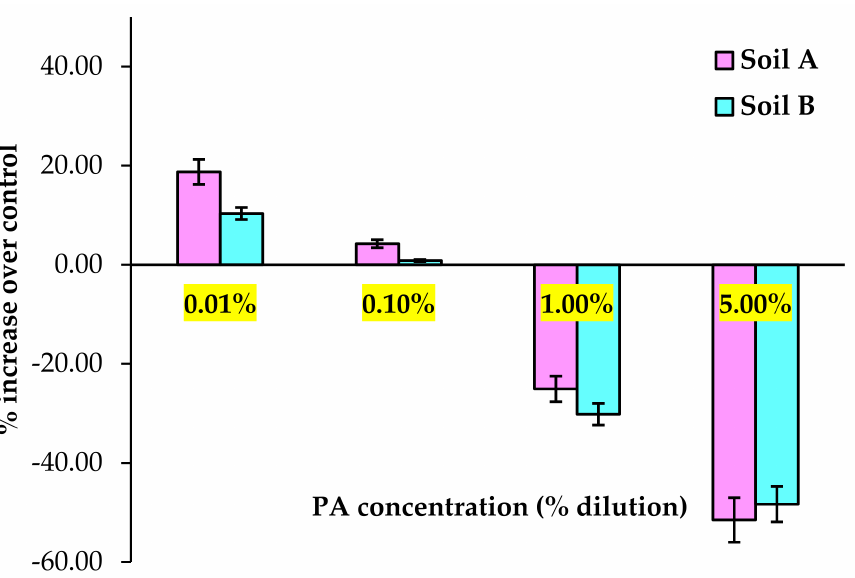
Figure 1. The effect of PA on soil dehydrogenase